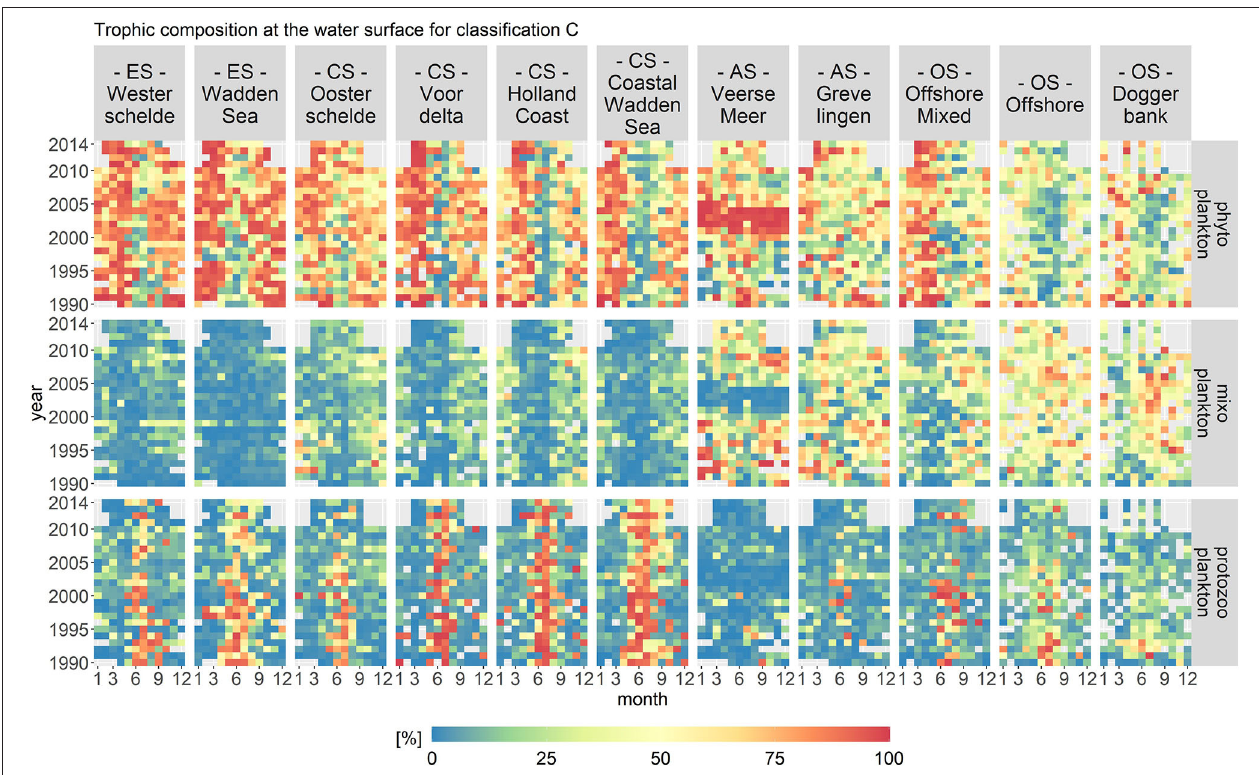
FIGURE 8 | Monthly fractions of the total biomass per trophic mode for trophic classification C. The location classes are grouped into estuary (ES), coastal (CS), anthropogenically modified (AS), and offshore systems (OS). The mixoplankton fraction displays a clear spatial and seasonal